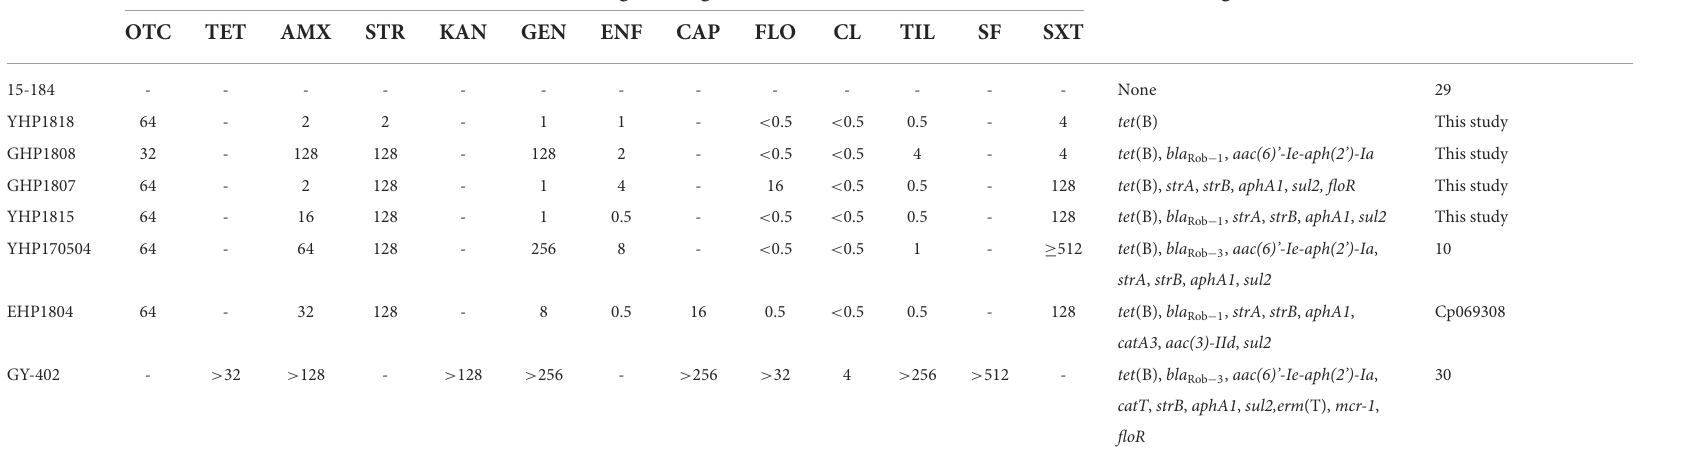
TABLE 3 MICs and resistance genes in host isolates.